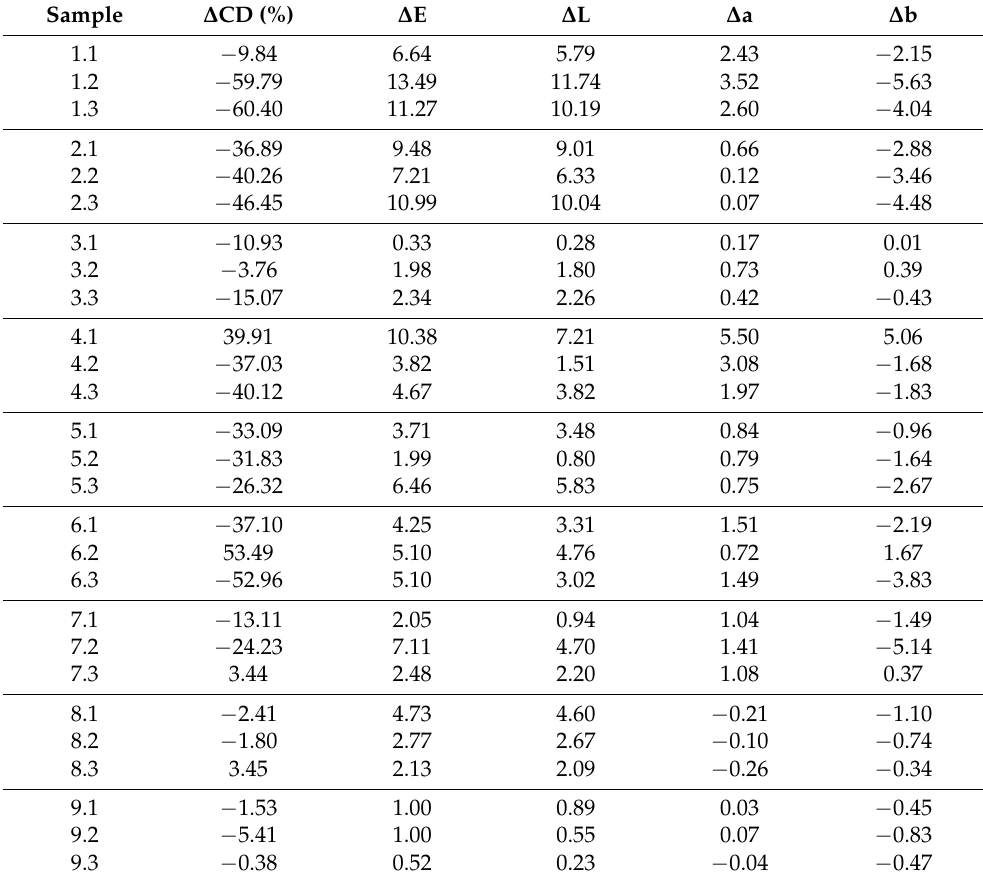
Table 2. Spectral reflectance data of the three fixed points (X.1–X.3) of every sample (1.X–9.X), with ∆ L, ∆ a and ∆ b representing changes of the CIE L*a*b* colour space between the start and end; ∆ E corresponds to the colour difference, and ∆ CD (%) refers to the percentual difference in chlorophyll